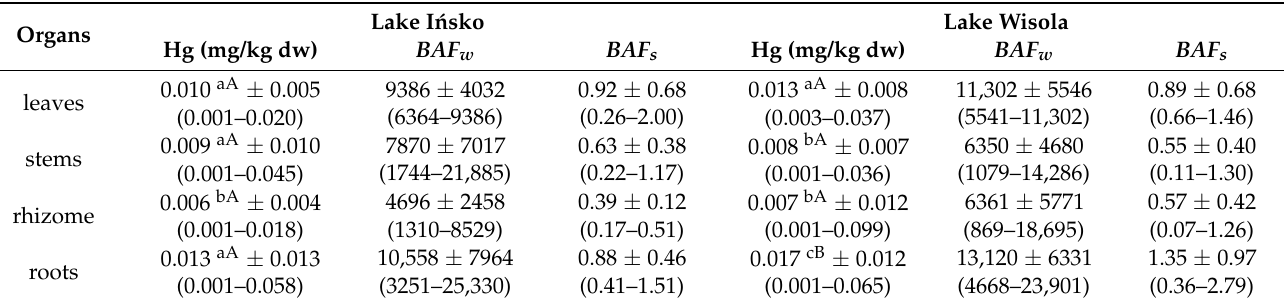
Table 4. Mercury content and bioaccumulation factors in organs of common reed (mean ±